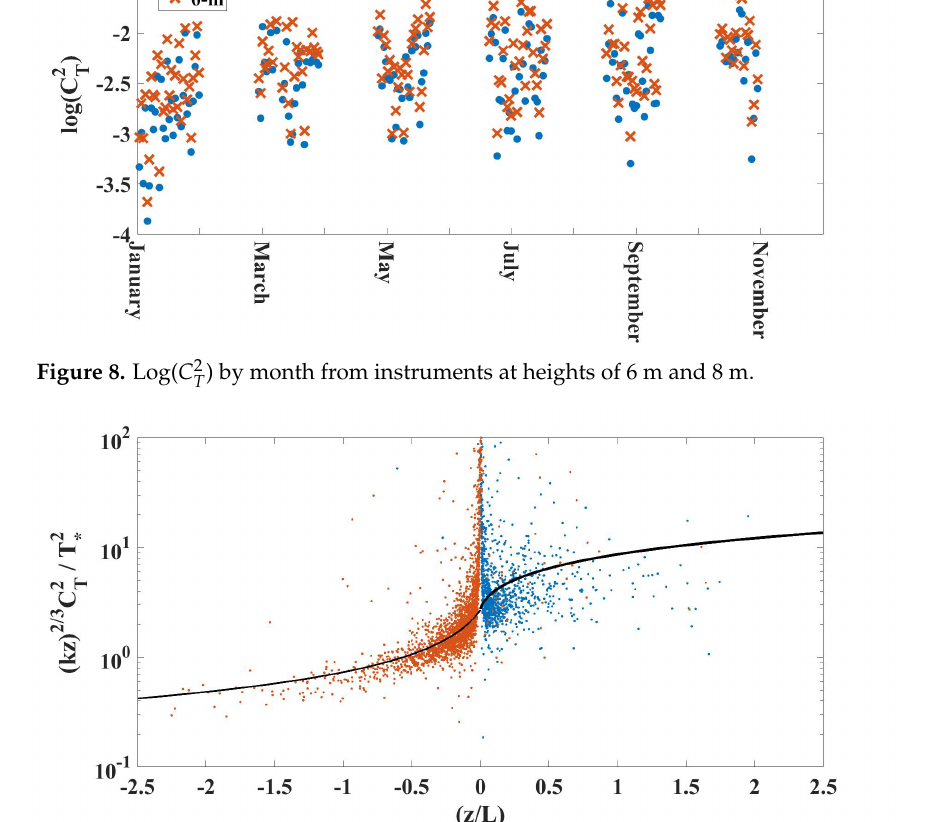
Figure 9. The Monin–Obukhov similarity function for the structure parameter of temperature vs. stability parameter.